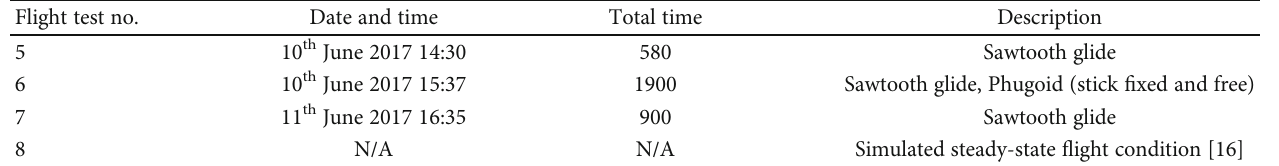
Table 2: Description of validation manoeuvres.